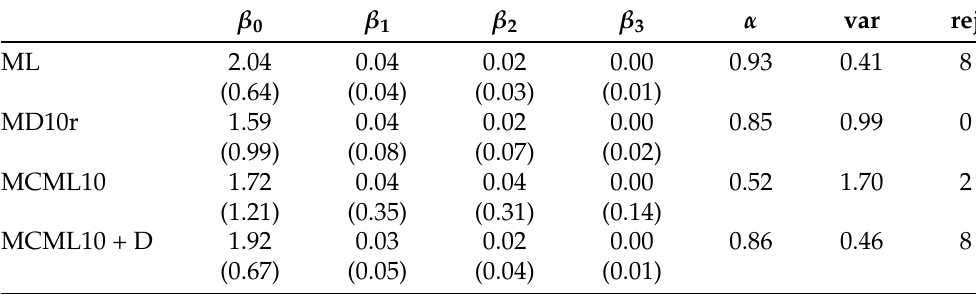
Table 6. Bootstrap coefficient means and standard errors of the ML, MDE10r, MCML10, and MCML10 + D estimators of the NB regression for length of stay data ( n = 50); var is the total variance; rej is the number of rejected